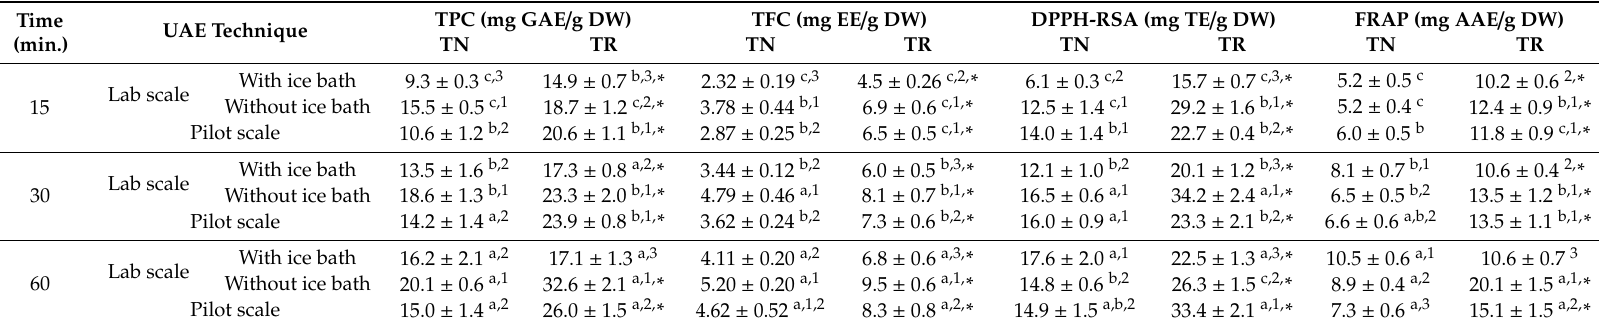
Table 1. Total phenolic content (TPC, mg gallic acid equivalents / g dry weight), total flavonoid content (TFC, mg epicatechin equivalents / g dry